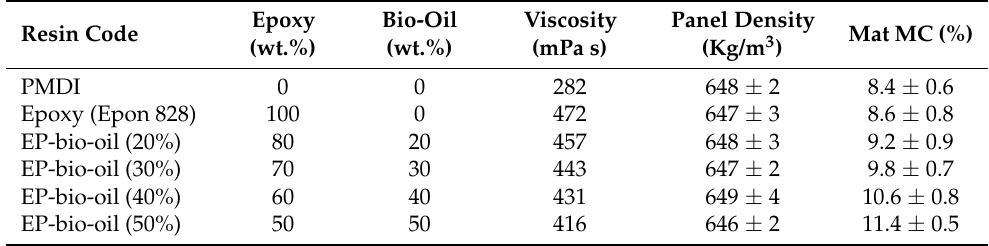
Table 2. Adhesive formulations with associated viscosities, panel density, and mat moisture content (MC